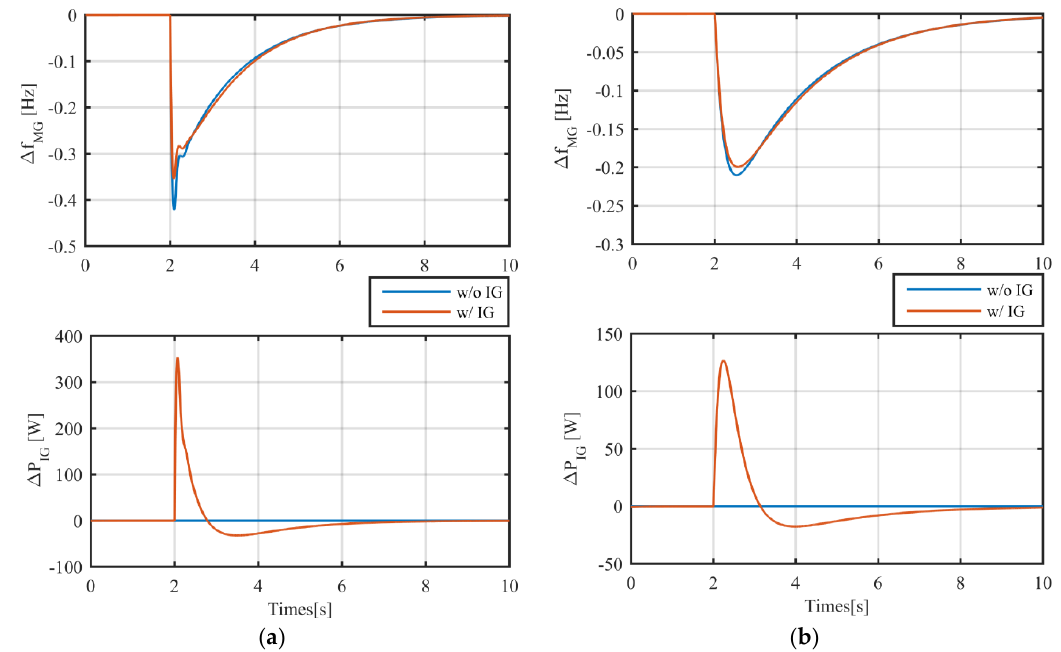
Figure 4. MG frequency deviation ( Δf MG ) and IG output power deviation ( ΔP IG ) for a 2 kW load connection, without and with IG connected: ( a ) H VSG = 1 s; ( b ) H VSG = 10 s.